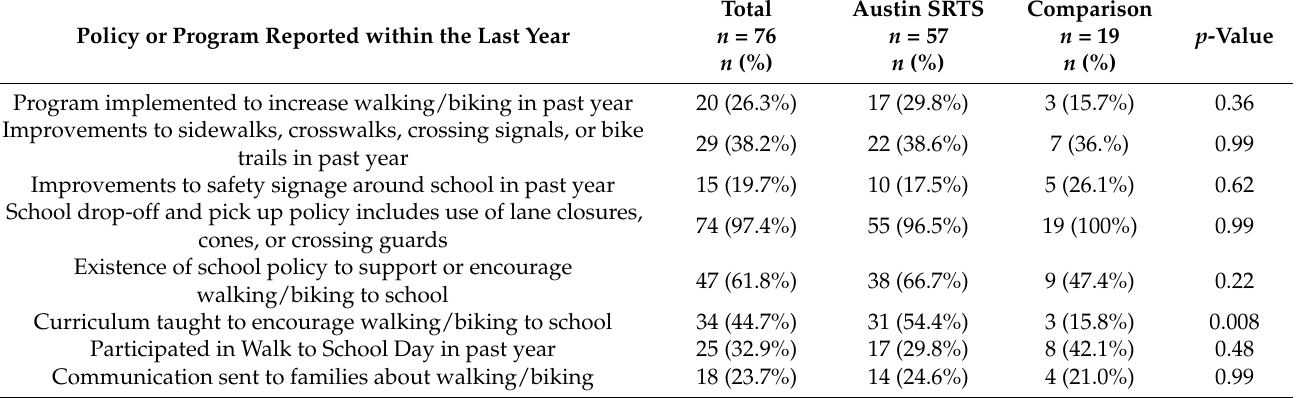
Table 3. Walking and biking school policies and programming from the Safe TRavel Environment Evaluation in Texas Schools (STREETS) school health policy